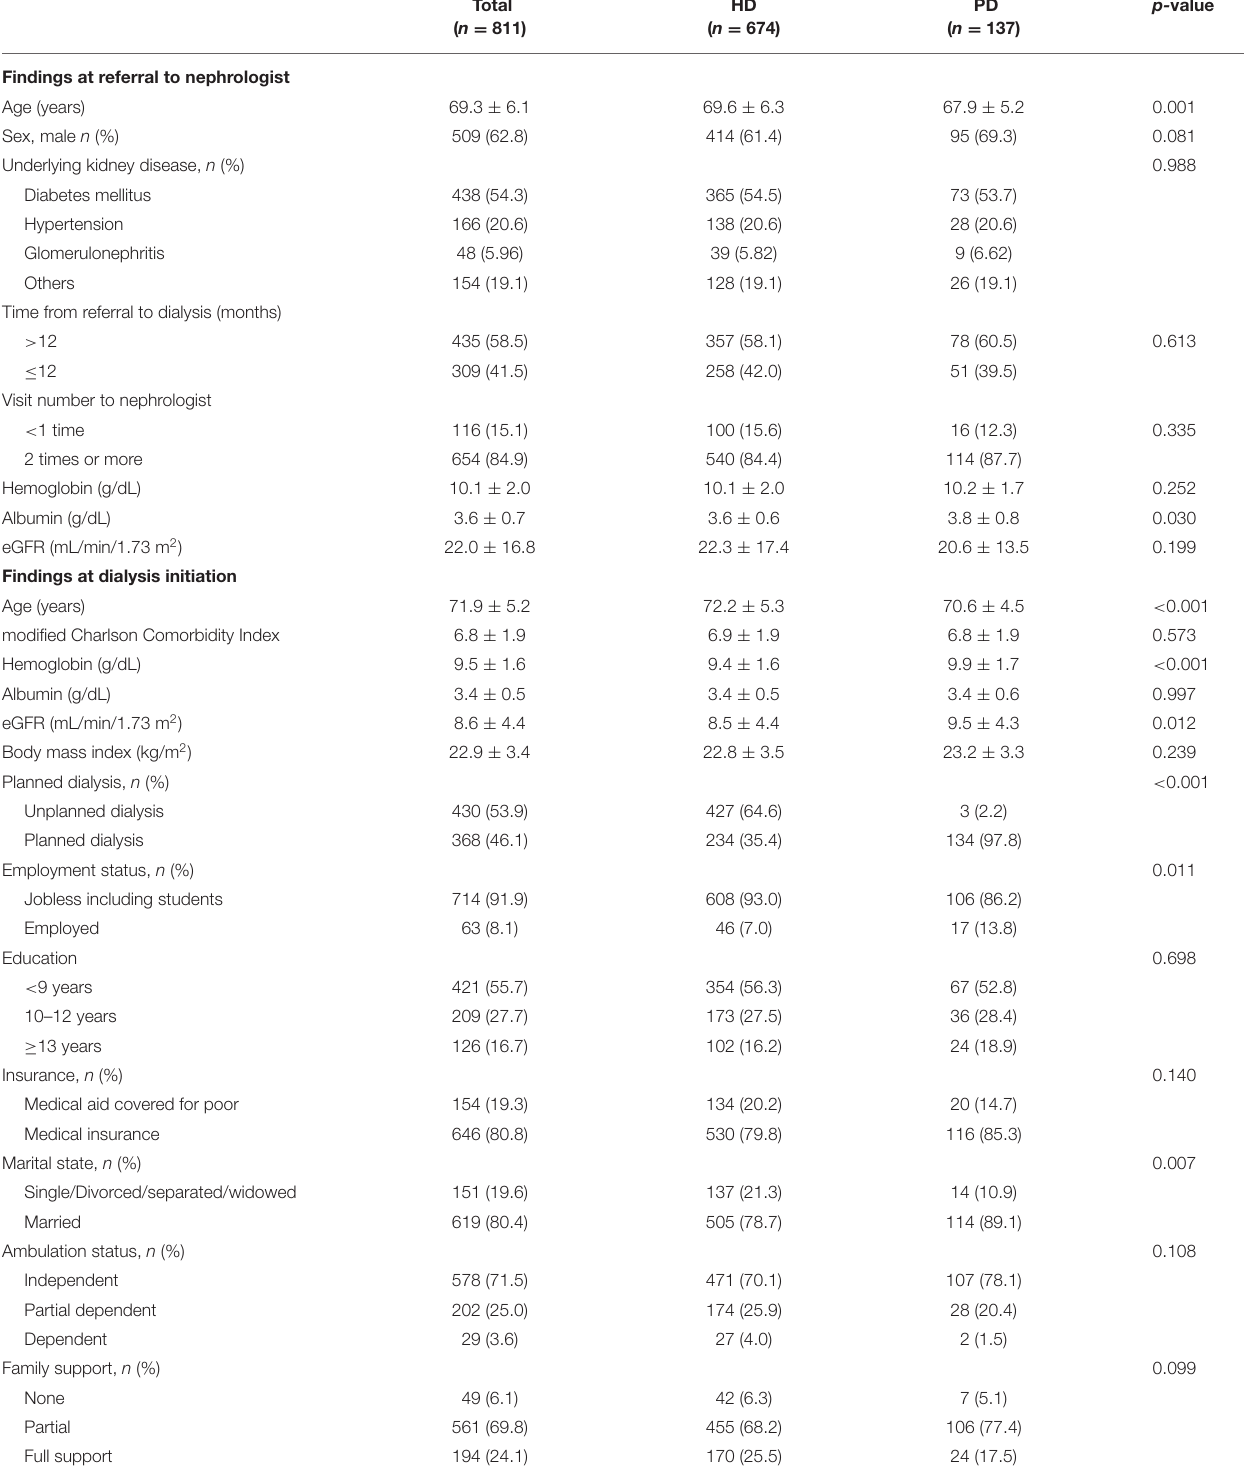
TABLE 4 | Information at referral to nephrologist and dialysis initiation by dialysis modality in elderly